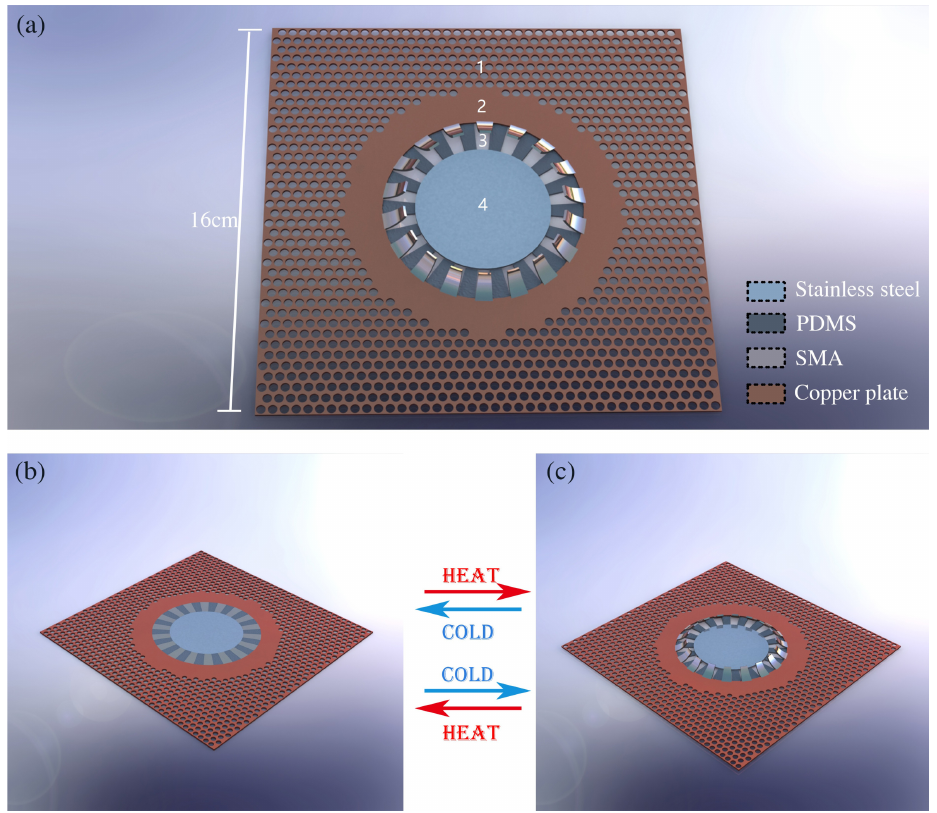
Figure 2. ( a ) Blueprint of our experimental sample. The holes on the sample filled with PDMS can be achieved by chemically etching. ( b ) The straightened SMA slices lead to cloak state of the bi-functional multi-physics device. ( c ) The tilted up SMA slices lead to the concentrator state of the bi-functional multi-physics device. The arrows in different colors implies the temperature variation can trigger the switching